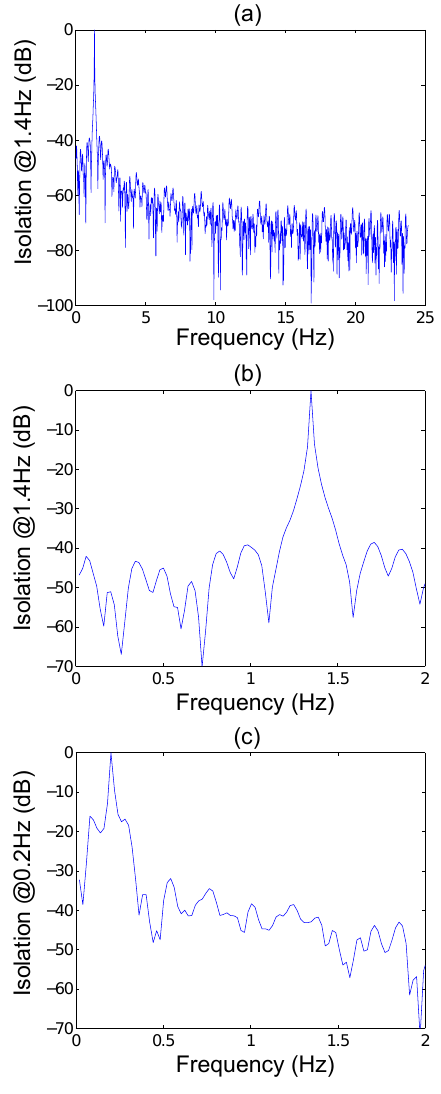
Fig. 4. Detector isolation: (a) around 1.4Hz center frequency to 25Hz; (b) around 1.4Hz center frequency to 2Hz; and (c) around 0.2Hz center frequency to